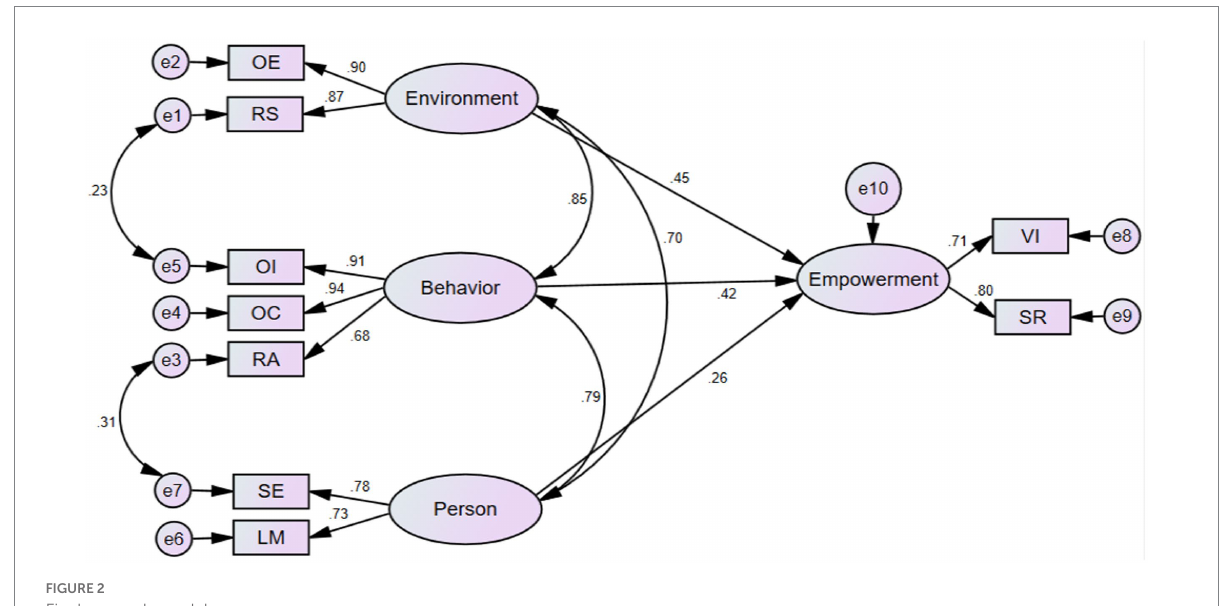
FIGURE 2 Final research model.